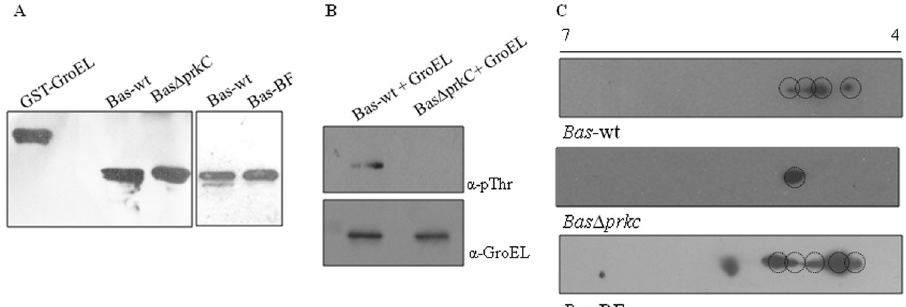
Fig. 3 GroEL expression and phosphorylation in B. anthracis : a Immunoblots show the expression of GroEL in B. anthracis cell lysates. Equal amounts of lysates (5 µg each) were used and probed with anti-GroEL antibodies. Puri fi ed GST-GroEL (0.5 µg) was taken as the positive control. Left panel shows the comparative expression of GroEL in Bas -wt and Bas Δ prkC . Right panel shows the comparative expression of GroEL in Bas - wt and Bas BF. b groEL was overexpressed and puri fi ed from B. anthracis strain, followed by immunoblotting with anti-pThr antibody. GroEL was phosphorylated in Bas-wt whereas no phosphorylation was observed with GroEL puri fi ed from Bas Δ prkC . c Two-dimensionally separated cell lysates of B. anthracis were probed with anti-GroEL antibodies to assess the stoichiometry of phosphorylation of native GroEL. Multiple species were observed in Bas -wt as compared with Bas Δ prkC , showing the in vivo phosphorylation of GroEL speci fi cally by PrkC. GroEL was hyper- phosphorylated during bio fi lm formation ( Bas BF) as observed by the increased number of spots ( third panel